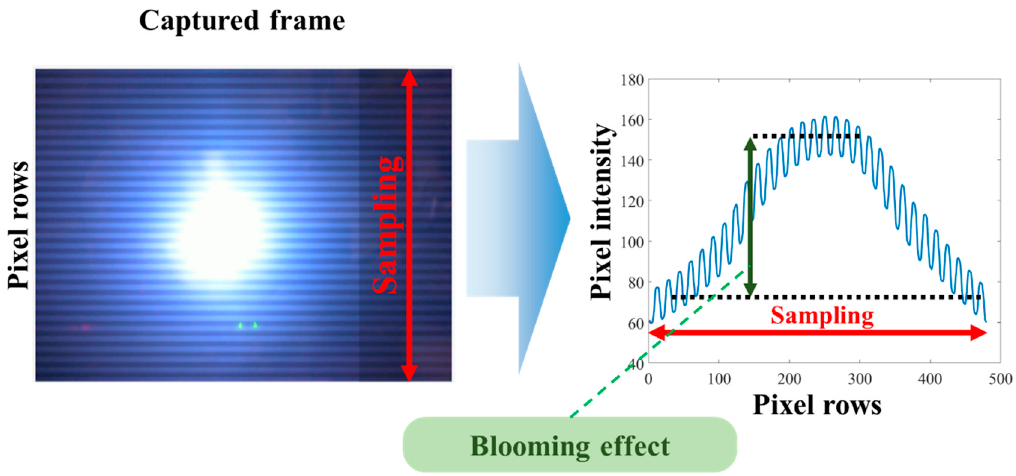
Figure 22. Blooming effect on RS-OCC.